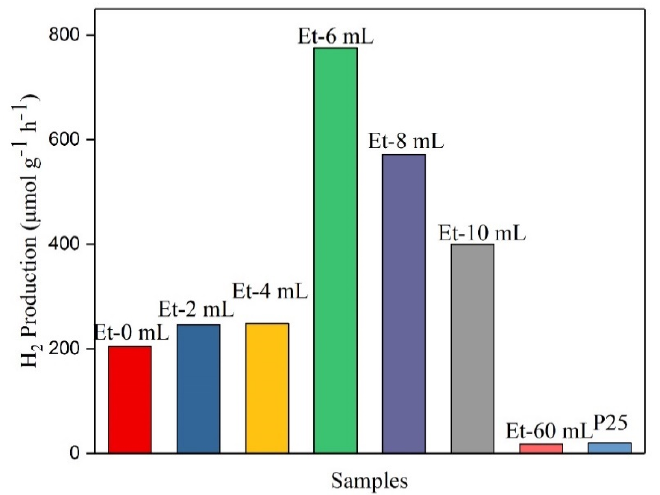
Figure 4. The photocatalytic data for hydrogen generation on crystalline microball samples and reference titania—P25.